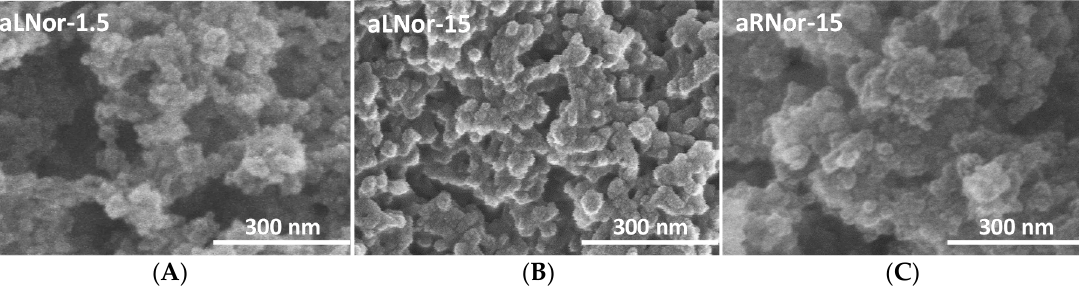
Figure 13. Representative SEM images of aLNor-1.5 ( A ), aLNor-15 ( B ), and aRNor-15 ( C ) (the two extreme sol concentration levels used in this study).